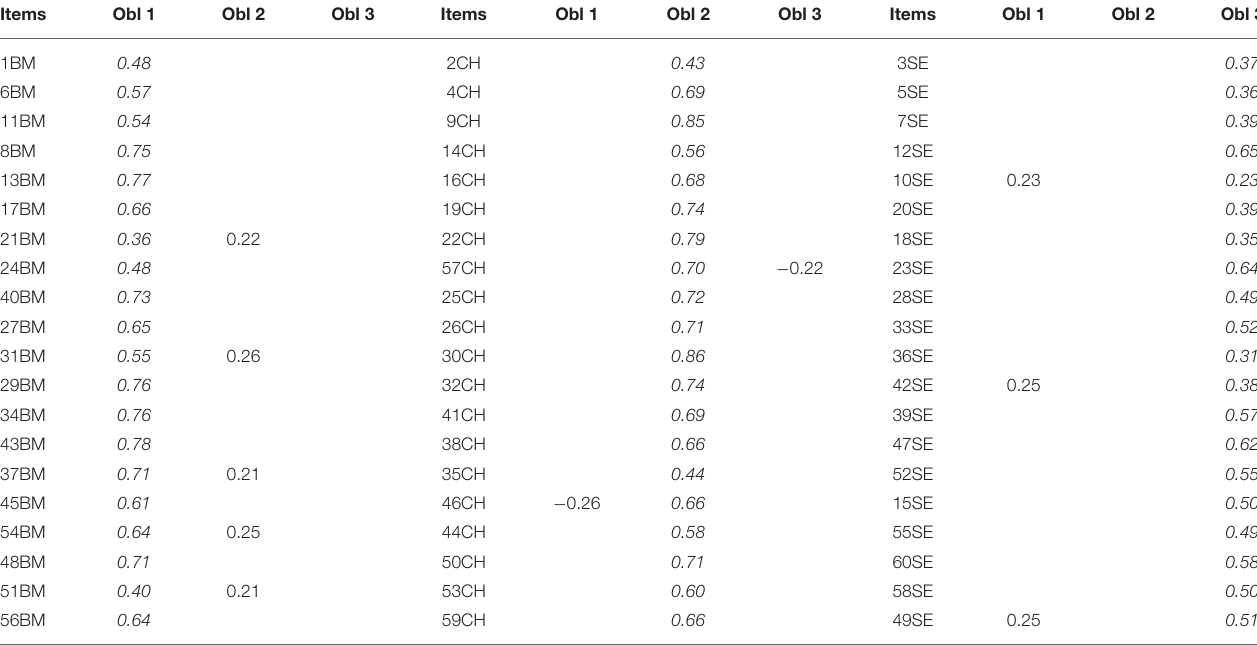
TABLE 10 | Loadings of the STCI–T < 60 > items on the three obliquely rotated factors in the construction sample.